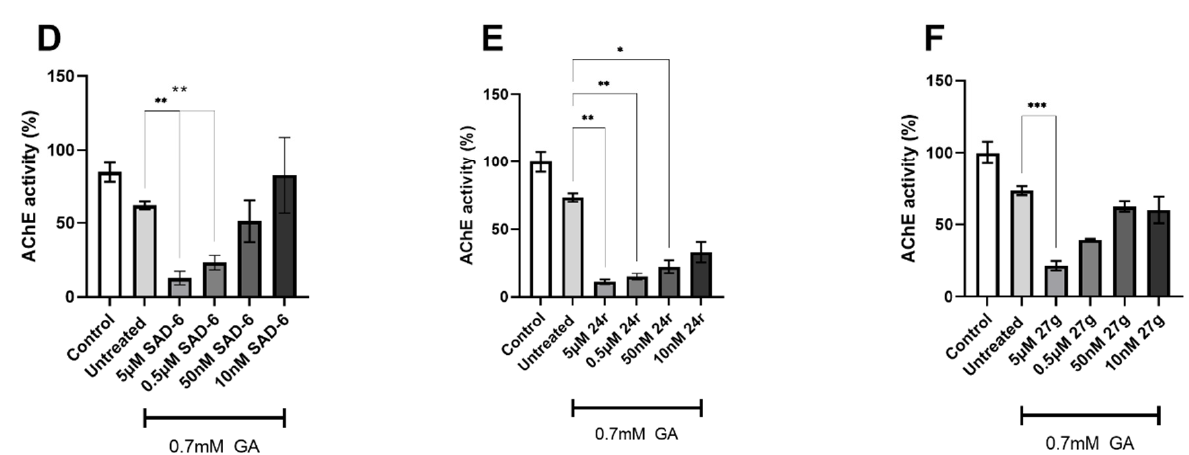
Figure 2. AChE inhibition by novel compounds at different concentrations in 0.7 mM GA-exposed SH-SY5Y-derived neurons. ( A ) Inhibitory activity of compound XJP-1 in 0.7 mM GA-exposed neurons. ( B ) Inhibitory activity of compound Donepezil in 0.7 mM GA-exposed neurons. ( C ) Inhibitory activity of compound SAD-2 in 0.7 mM GA-exposed neurons. ( D ) Inhibitory activity of compound SAD-6 in 0.7 mM GA-exposed neurons. ( E ) Inhibitory activity of compound 24r in 0.7 mM GA-exposed neurons. ( F ) Inhibitory activity of compound 27g in 0.7 mM GA-exposed neurons. Ordinary one-way ANOVA followed by Tukey’s post-hoc test was used to compare differences between different groups. Data are presented as mean ± SEM. n = 3. * p < 0.05; ** p < 0.01; *** p < 0.001; **** p < 0.0001.